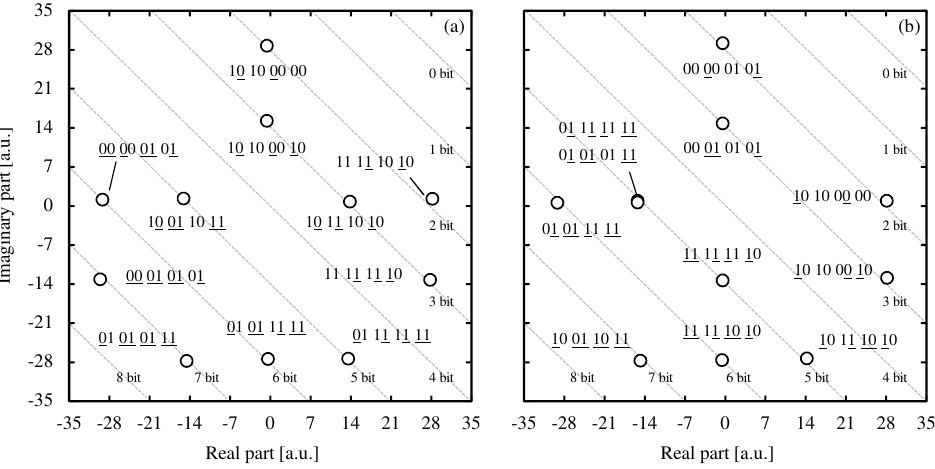
Figure 6. Constellations of the 8-bit optical comparator: ( a ) “11 10 10 00” comparator. ( b ) “00 10 01 00” comparator. In these figures, all constellations are located in conformity with the Hamming distance based on the comparator codes “11 10 10 00” and “00 10 01 00”, respectively. The inconsistent bits with the comparator code are underlined in each